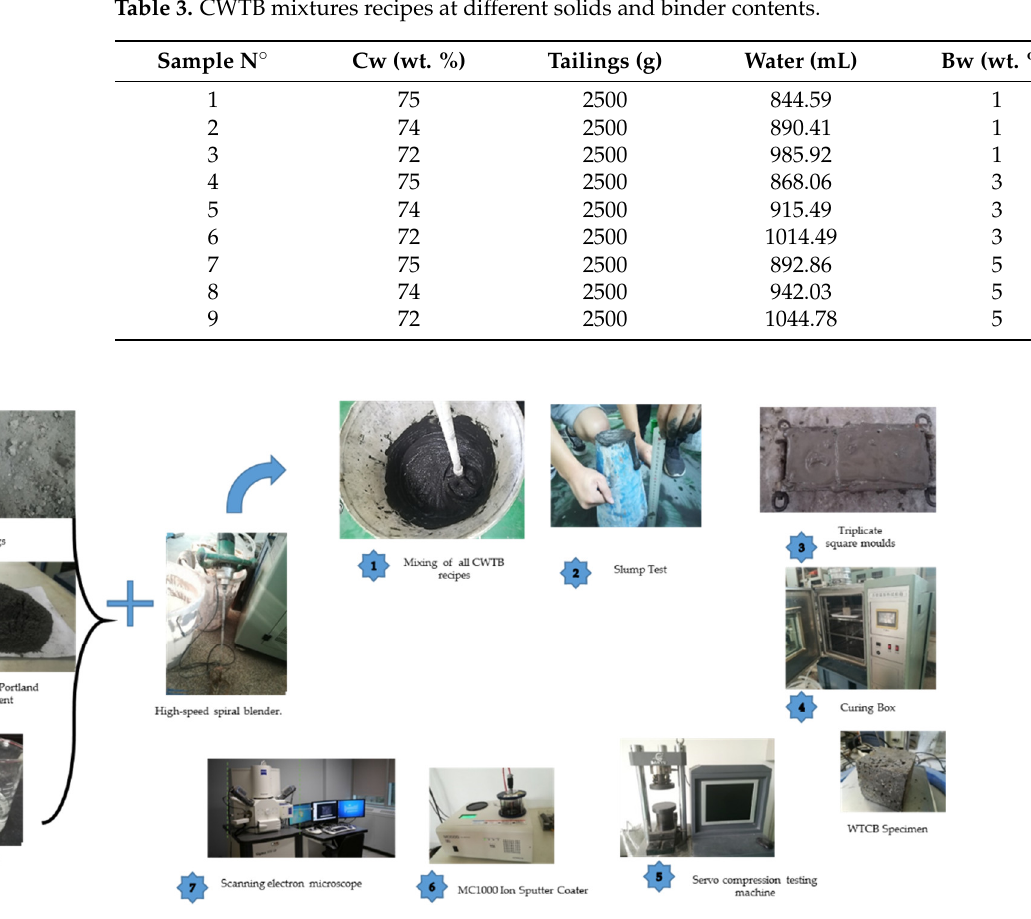
Figure 3. Experimental technical route of CWTB preparations.